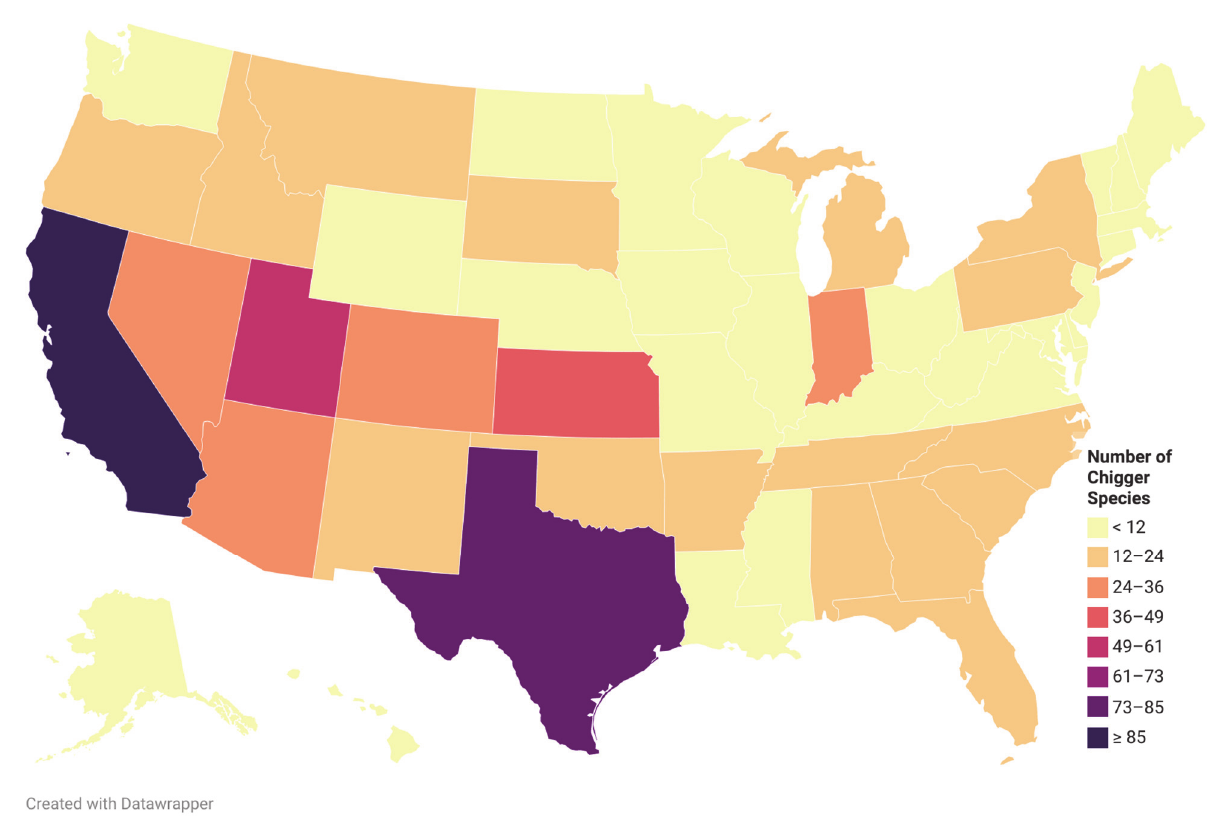
Figure 4. Chigger species richness in the US. Created with Datawrapper. Data sources: [17,45].